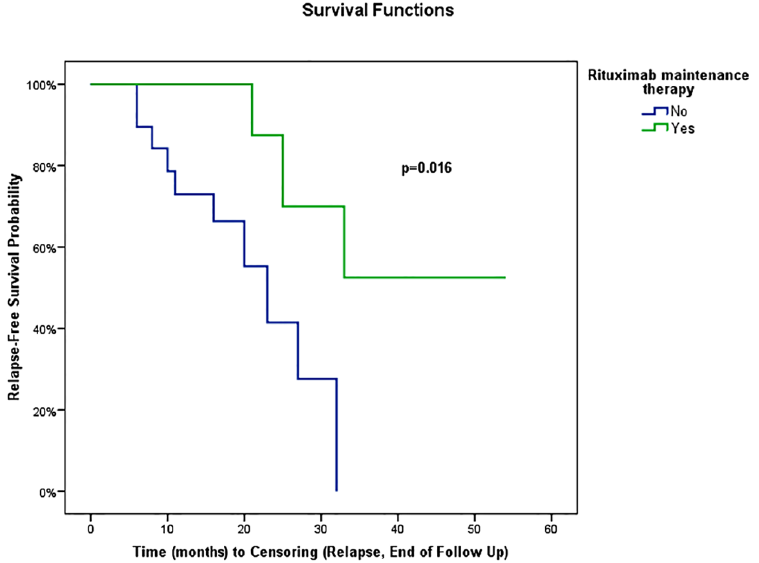
Fig 4. Risk of disease relapse for patients with or without “prophylactic” maintenance therapy with rituximab.